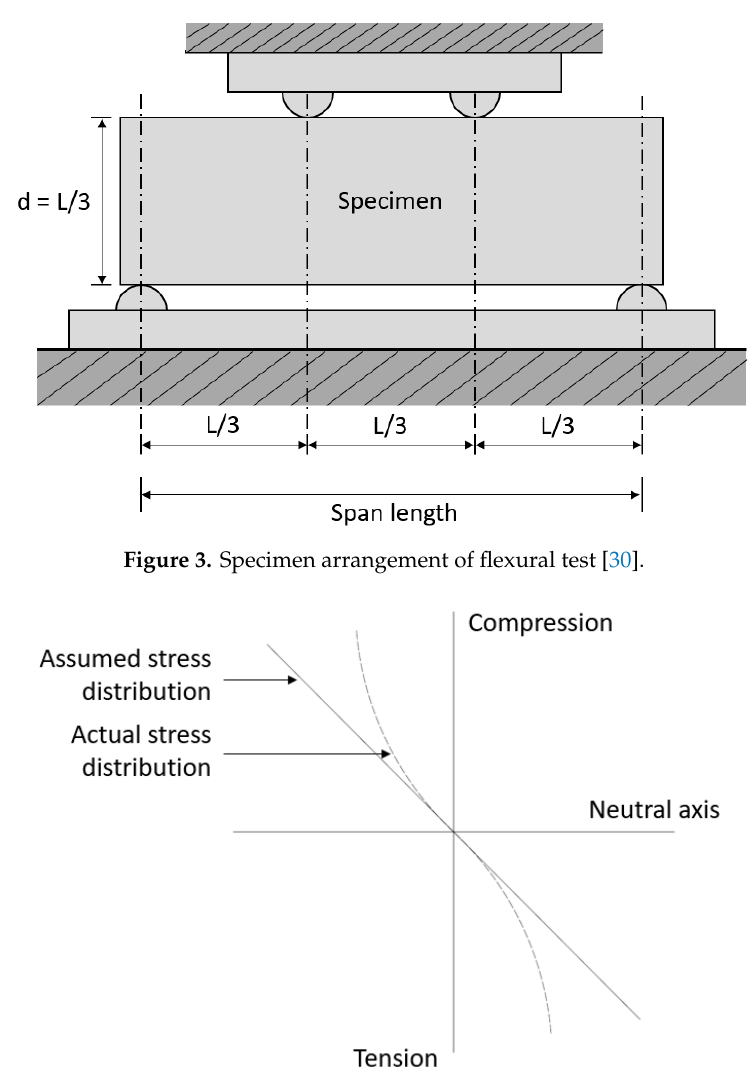
Figure 4. Stress distribution across specimen depth in flexural test [2].